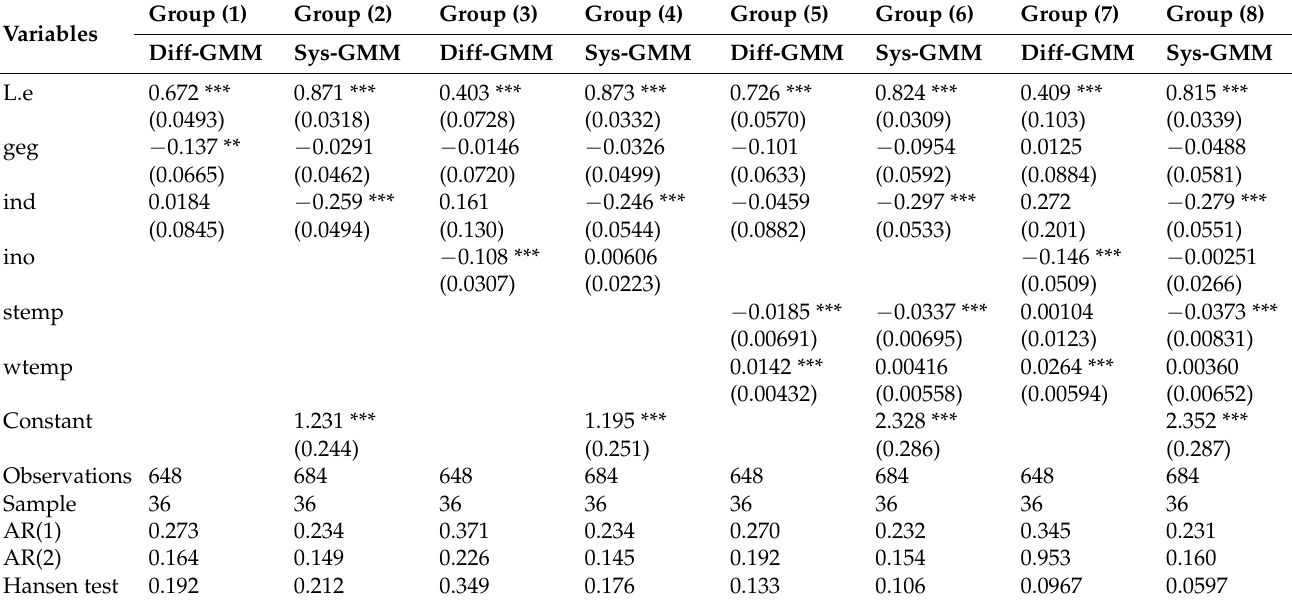
Table 7. The energy consumption function